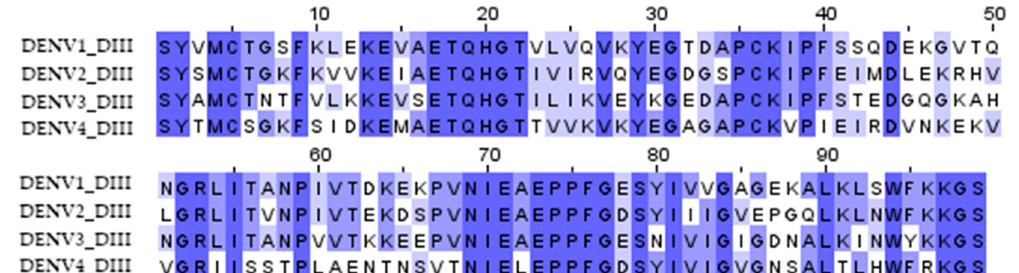
Figure 1. Multiple sequence alignment of the DIII domain amino acid residues of the dengue virus serotypes 1 (aa 578–676, record ID NP_059433), 2 (aa 578–676, record ID NP_056776), 3 (aa 576–674, record ID YP_001621843), and 4 (aa 577–675, record ID NP_073286) used to obtain the d34 antigen